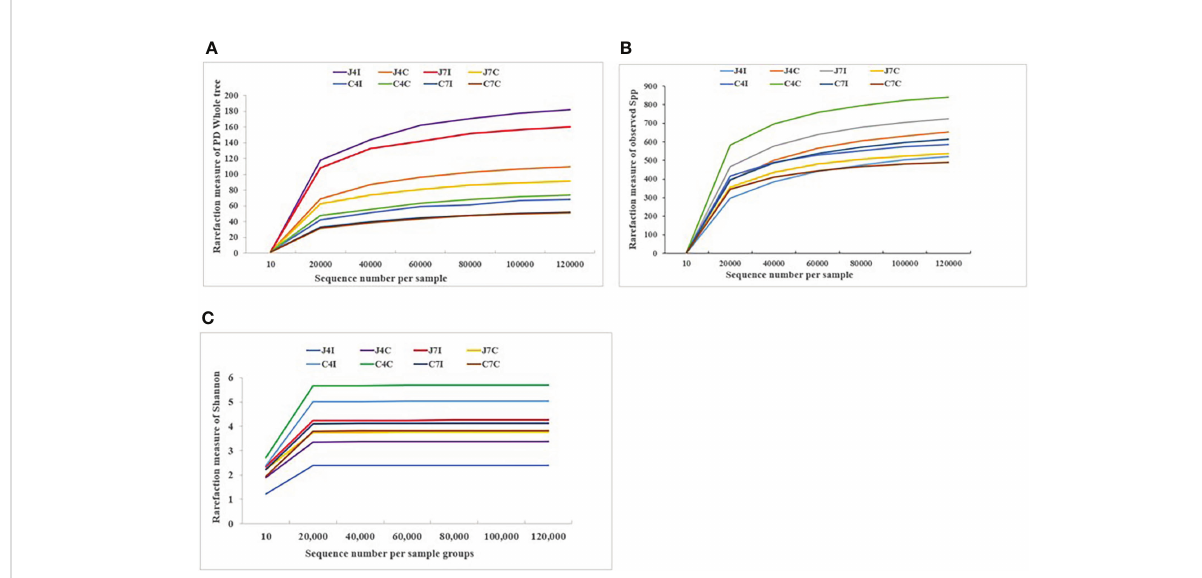
FIGURE 1 Rarefaction curve plot of sequences number per sample group. (A) Observed species. (B) PD Whole tree. (C) Shannon.